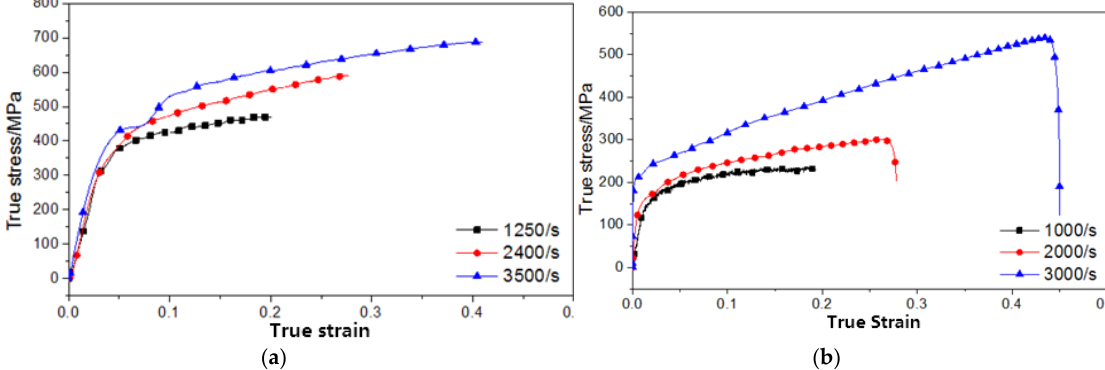
Figure 4. Stress–strain curves of the porous titanium alloy specimens (porosity: 26% and 36%) at the same temperatures but different strain rates: ( a ) ε p = 26%, T = 25 °C; ( b ) ε p = 36%, T = 25 °C; ( c ) ε p = 26%, T = 100 °C; ( d ) ε p = 36%, T = 100 °C; ( e ) ε p = 26%, T = 200 °C; ( f ) ε p = 36%, T = 200 °C; ( g ) ε p = 26%, T = 300 °C; and ( h ) ε p = 36%, T = 300 °C.